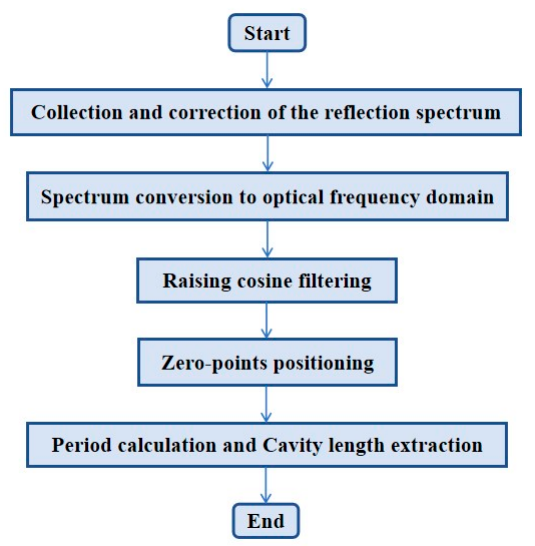
Figure 3. Flowchart of the zero-cross detection algorithm for cavity-length interrogation of fiber-optic FP sensors.